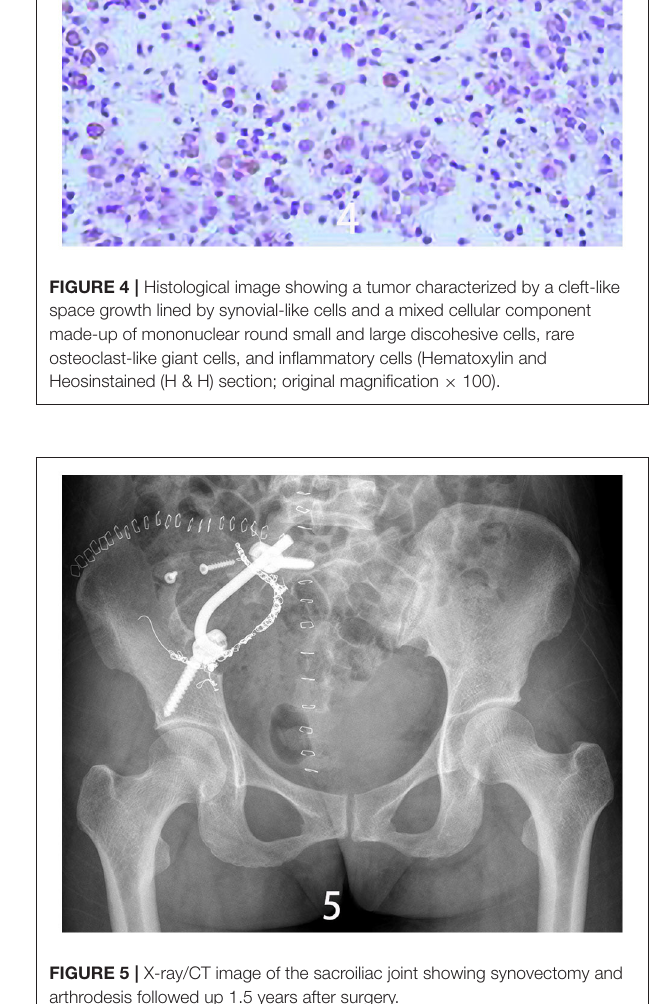
obvious signs of the disease, which may lead to missed diagnosis and misdiagnosis. The proportion of patients with PVNS with normal or possible non-specific soft tissue swelling on X-ray examination was 54% (6).CT can clearly show bone destruction area and low-density liquefaction necrotic area. Meanwhile, a CT-guided synovial biopsy can be further performed to confirm the diagnosis. MRI examination is the best non-invasive method for the diagnosis of PNVS (7). On MRI, villous nodules show marked hypo-intensity changes at T 2 W I, which are characteristic of pigmented villous nodular synovitis. This is due to the high content of hemosiderin in the villous nodules, whose paramagnetism significantly reduces the T 2 relaxation